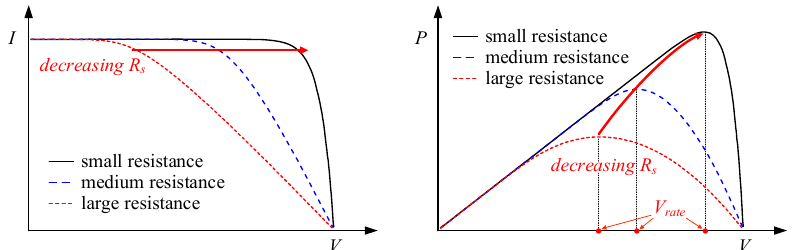
Figure 6. I–V and P–V properties for different R s values.